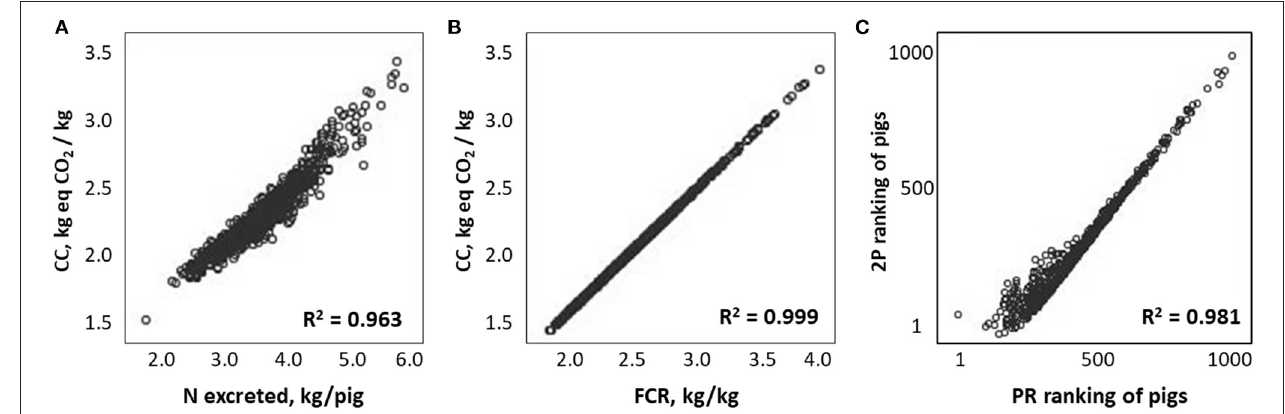
FIGURE 1 | Relationships between climate change (CC) impact and nitrogen excreted (A) or feed conversion ratio (FCR, B ), and effect of feeding program on ranking of pigs according to CC impact (C) ( N = 1,000 pigs). lower than with NE, with r values ranging between 0.42 and